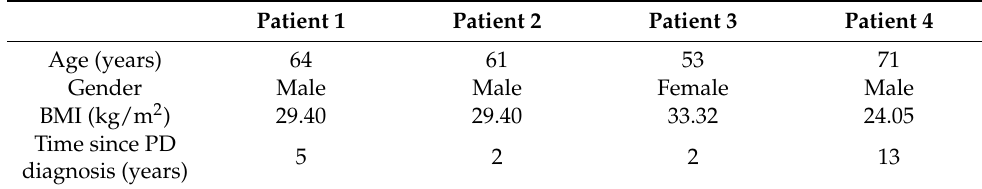
Table 1. Demographic characteristics of the